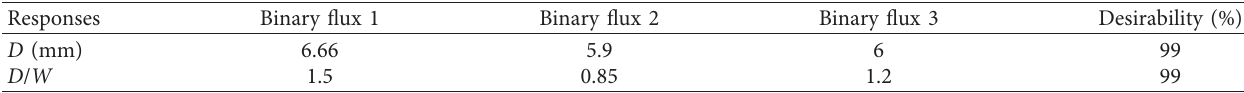
Table 8: Predicted responses (D, D/W) of weld executed with optimal flux.